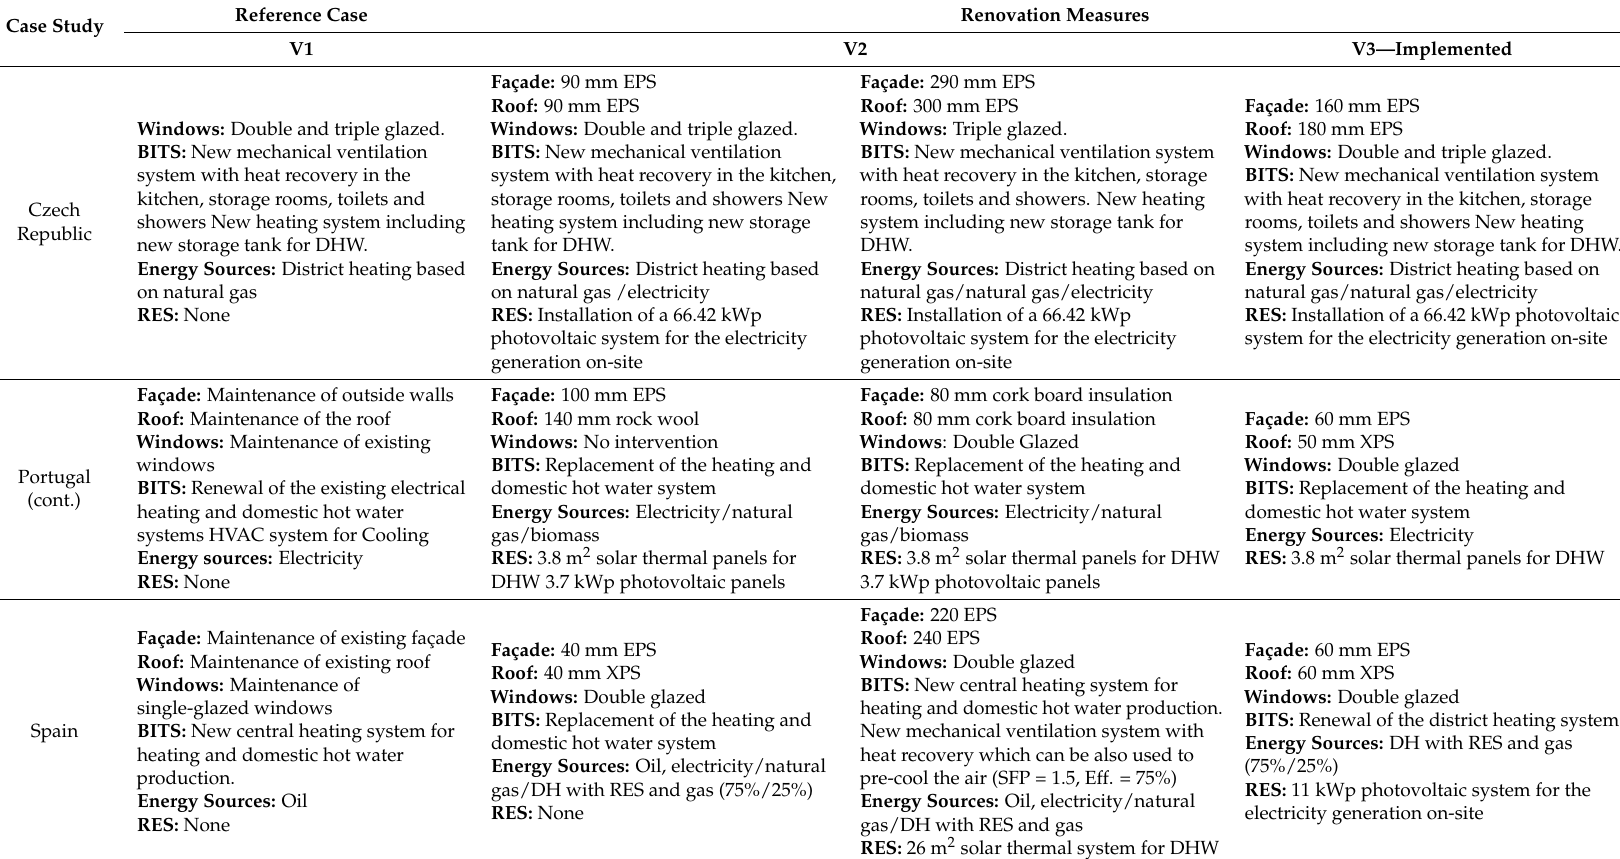
Abbreviations used in this table: BITS—building integrated technical systems; RES—renewable energy sources; DH—district heating; DHW—domestic hot water; HVAC—heating, cooling and air conditioning; Kwp—kilowatt peak; U Value—thermal transmittance of a building element in W/m 2 K; EPS—expanded polystyrene insulation; XPS—extruded polystyrene insulation; SPF—specific fan power (Kw/(m 3